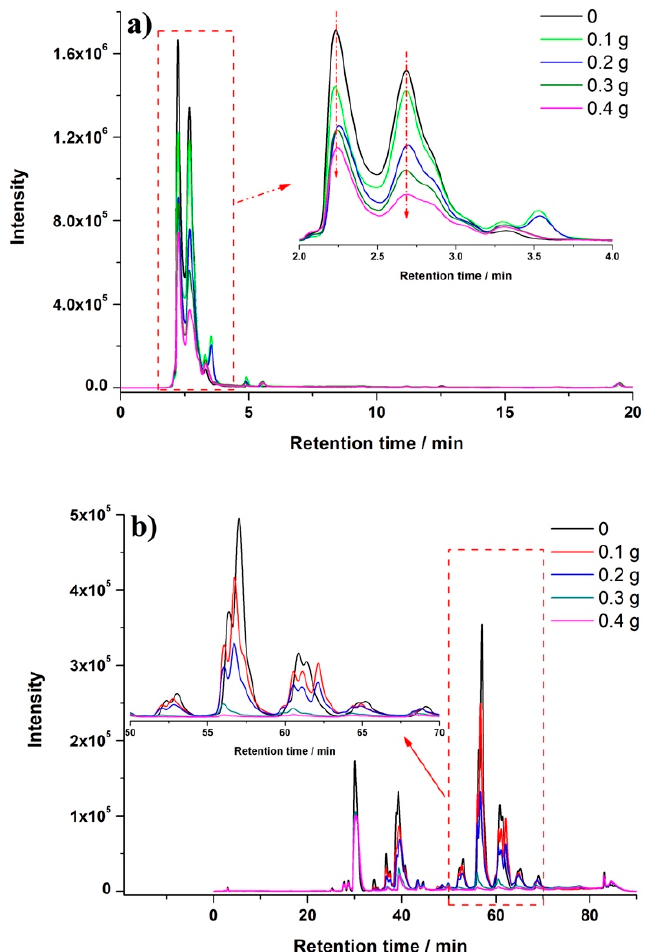
Figure 3. Representative HPLC-fluorescence detector (FLD) chromatograms of ( a ) bisphenol standards, ( b ) spiked bee pollen sample, and ( c ) blank bee pollen sample. Peak 1: bisphenol A (BPA); 2: bisphenol B (BPB); 3: internal standard (IS). The spiked concentrations in ( b ) were 60 μ g/kg and 80 μ g/kg for BPA and BPB, respectively.